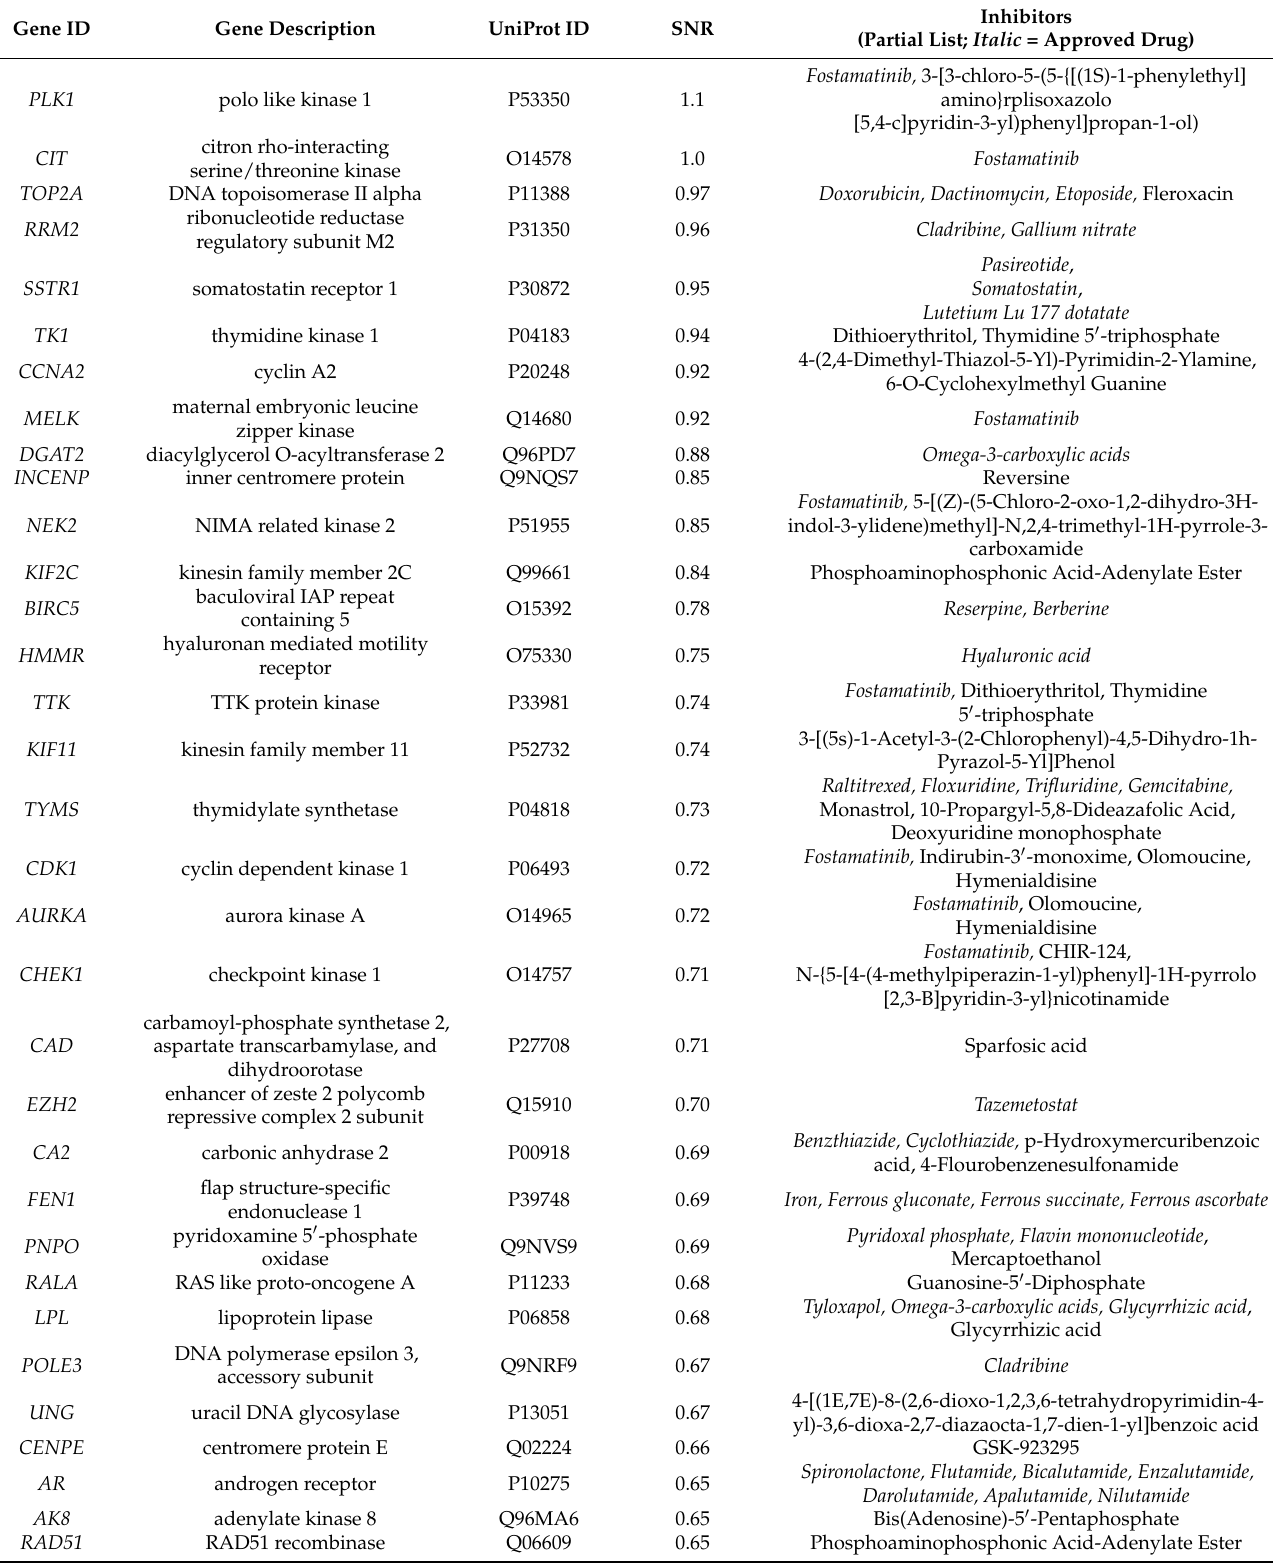
Table 3. List of the most highly upregulated (metastasis vs. PT) genes coding for proteins with known inhibitors according to Drug Bank. SNR = signal-to-noise ratio (metastasis vs. PT); permutation p -value for all genes =